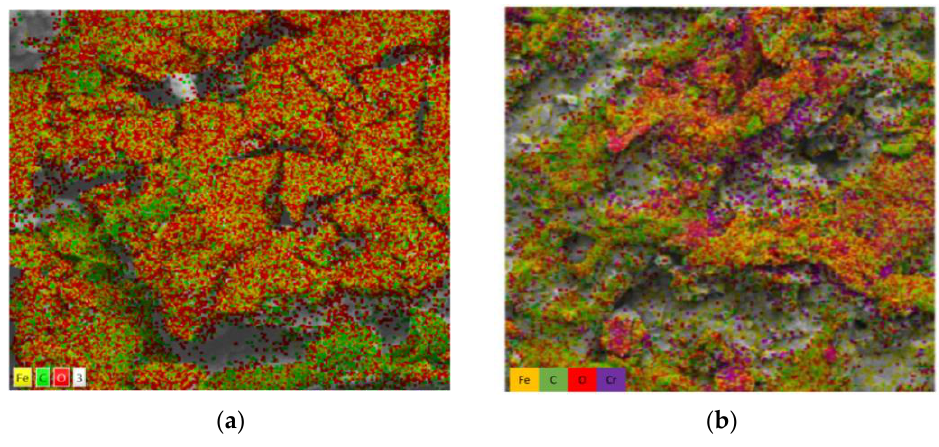
Figure 3. Micrograph of ECFe a) fresh biomass b) after Cr (VI) adsorption.